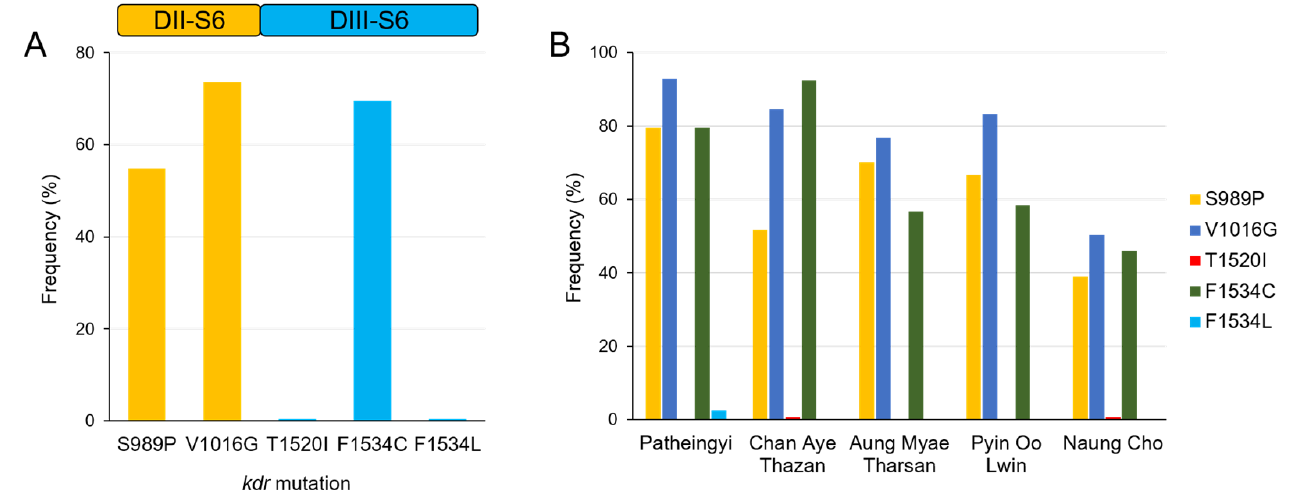
Figure 2. Frequencies of major kdr mutations associated with pyrethroid resistance in Ae. aegypti populations collected in Mandalay area, Myanmar. ( A ) Frequencies of major kdr mutations detected in vgsc DII-S6 and DIII-S6 of Myanmar Ae. aegypti populations. ( B ) Frequencies of major kdr mutations detected in Myanmar Ae. aegypti populations collected at 5 townships, Mandalay area, Myan- mar.